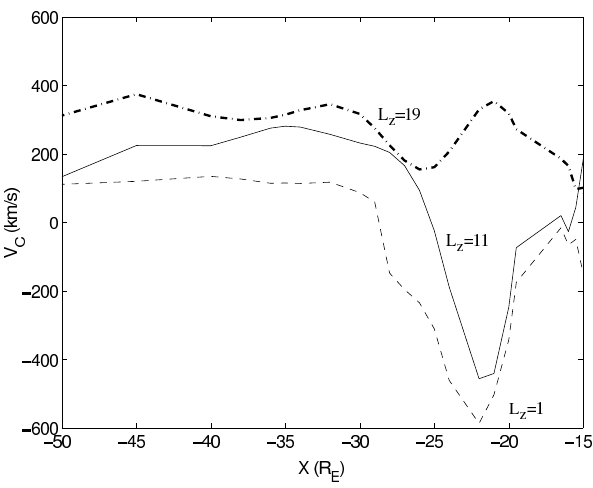
Fig. 19. Model velocity moments in the V C ( ≈ V x ) direction calcu- lated in the magnetotail CS region ( Z = 0 . 0001 R E ). The moments are shown for three different current sheet half-thickness parameters ( L z = 1 , 11 , 19). L z has been normalised to L z = 1 ≡ 0 . 05 R E